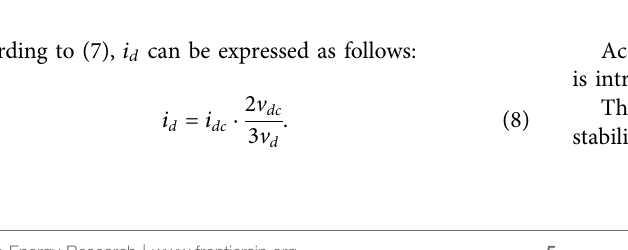
Frontiers in Energy Research |